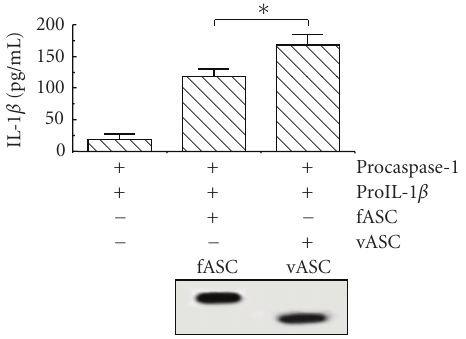
Figure 4: Comparison of excreted IL-1 β levels. IL-1 β in the culture medium of Cos7 cells cotransfected with expression vectors ( procaspase-1 and proIL-1 β with fASC or vASC) was measured by ELISA. Results are shown as mean ± SE . n = 3, ∗ P < . 05. Expression levels of fASC and vASC are shown under the graph.